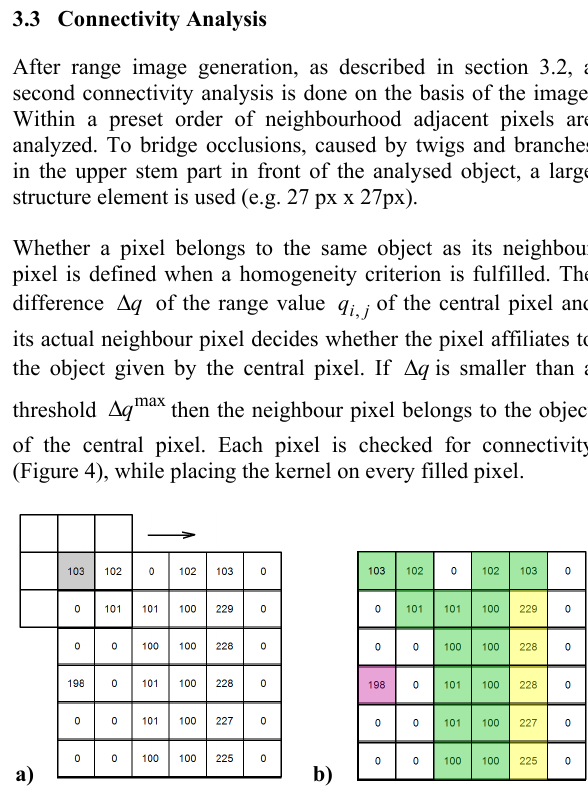
Figure 4. Principle of connectivity analysis with a 3 x 3px kernel: a) range image with range values ji q , ; b) segmented range image (Bienert,